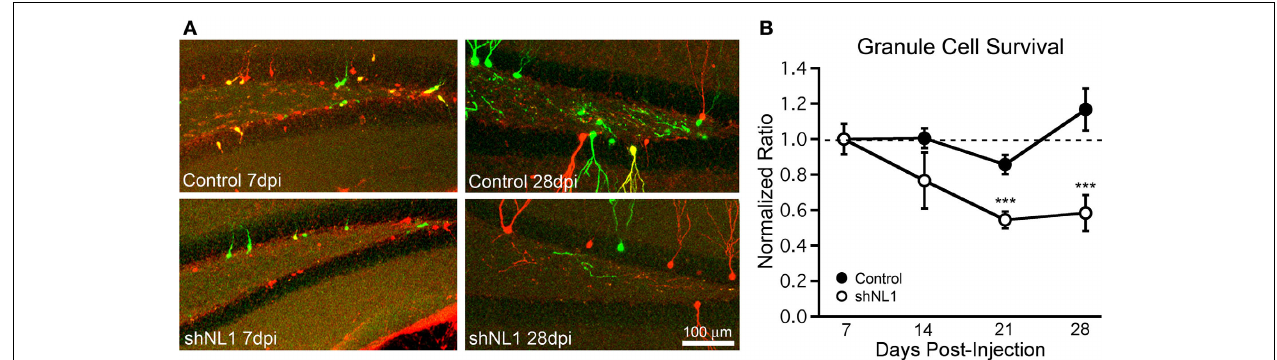
FIGURE 5 | Neuroligin-1 knockdown reduces newborn granule cell survival. (A) Representative images of dentate gyrus, containing retrovirus-labeled newborn cells from co-injection survival experiments. Equal volumes of two viruses (GFP- and mCherry-coding) were injected, and animals were perfused at varying timepoints after injection. In control animals, GFP viruses were vector controls. In shNL1 animals, GFP viruses contained an shRNA against neuroligin-1. At 7 dpi (left panels), cell somata were smaller, predominantly located at the subgranular zone with rudimentary dendrites. GFP + and mCherry + tracks are overlaid; cells